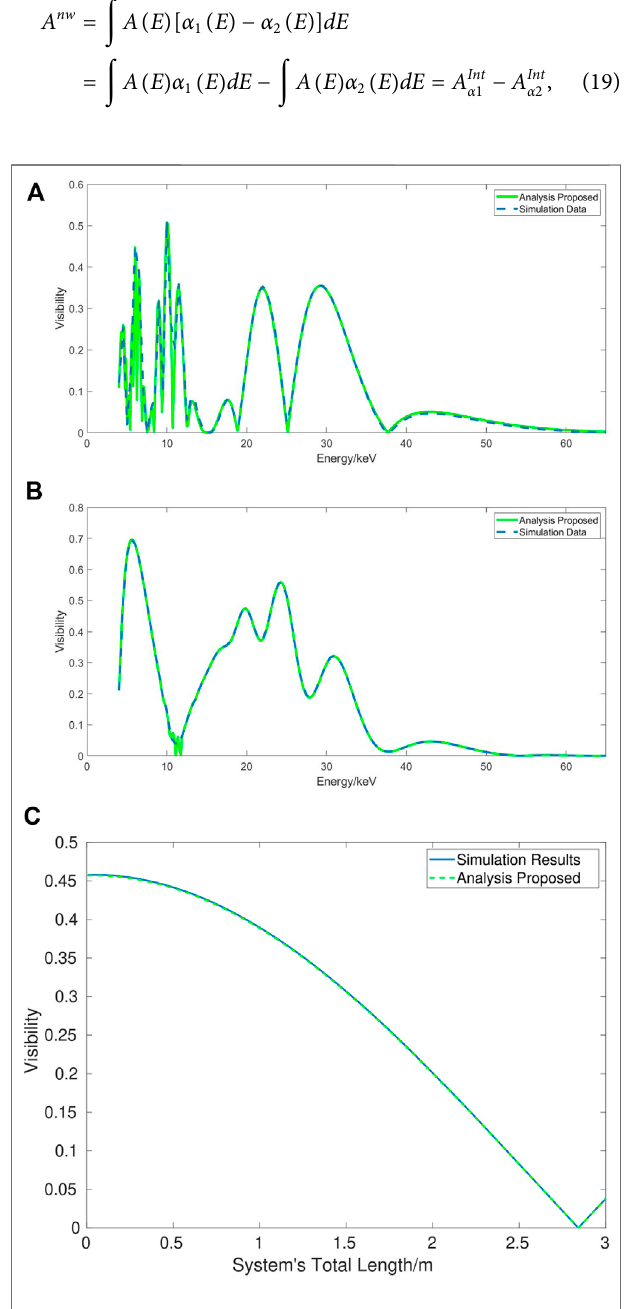
FIGURE 2 | Comparison of the simulation results and the analysis proposed. (A) , Visibility of System 1 (Talbot-Lau) at different monochromatic source energy. (B) , Visibility of System 2 (Projection) at different monochromatic source energy. (C) , Visibility of System 2 with 35-kV tungsten X-ray tube and different system total length.